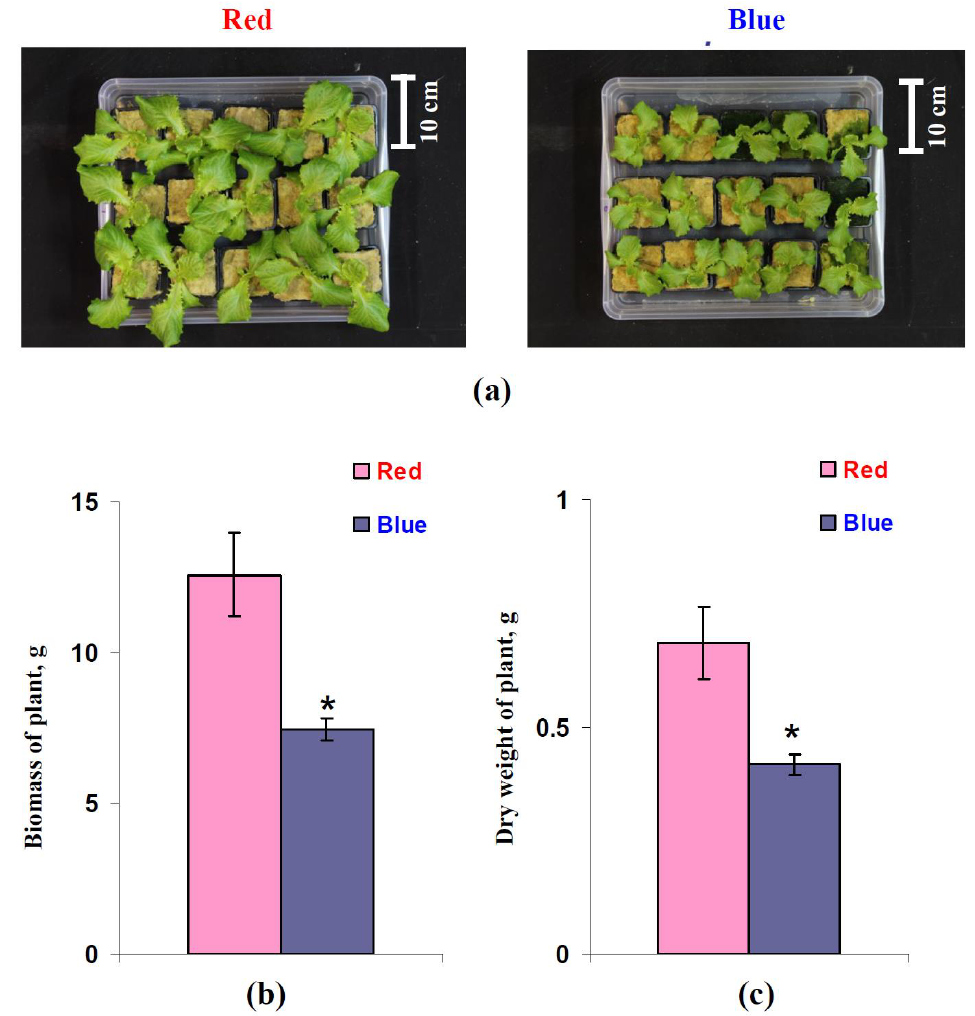
Figure 10. Examples of lettuce plants after 25 days of cultivation under the red (marked as “Red”) and blue (marked as “Blue”) illumination variants ( a ), the averaged biomass ( b ), and dry weight ( c ) of these plants ( n = 8). The fresh and dry weight were calculated per plant. * differences between plants cultivated under the red and blue illumination variants were significant ( p < 0.05).